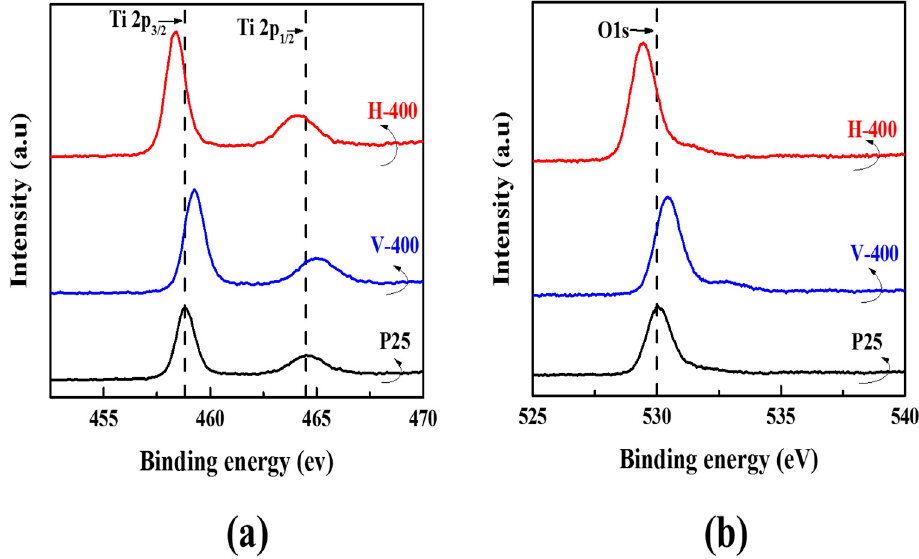
Figure 2. ( a ) UV-vis spectra, ( b ) colour turning image and energy band gap of samples.